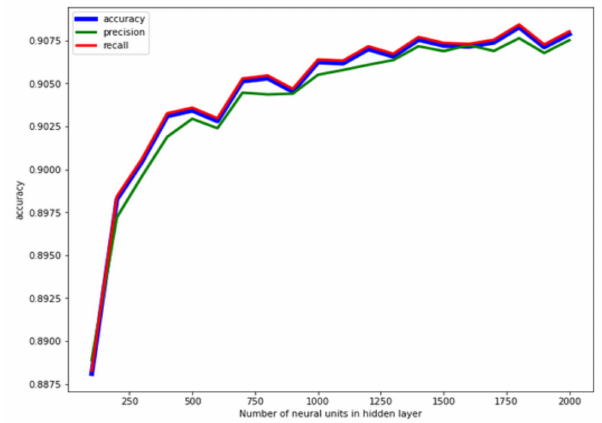
Figure 10. Influence of number of neurons in the hidden layer on the model.